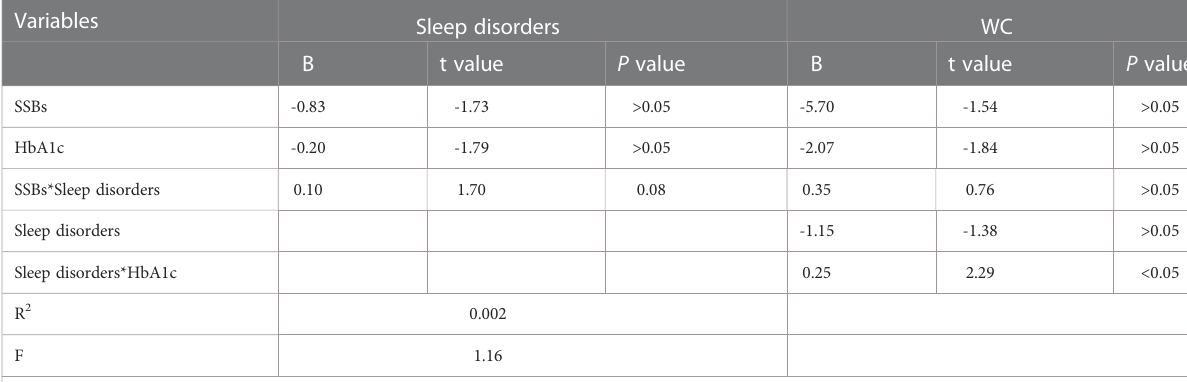
TABLE 9 Model characteristics for the conditional process analysis.